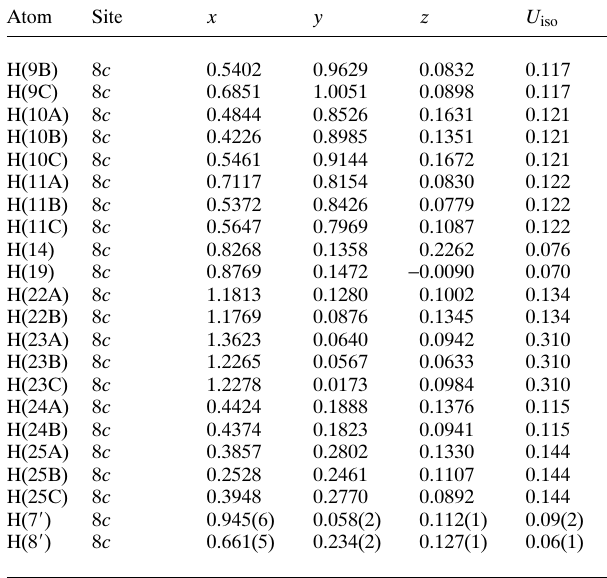
Table 1. Data collection and